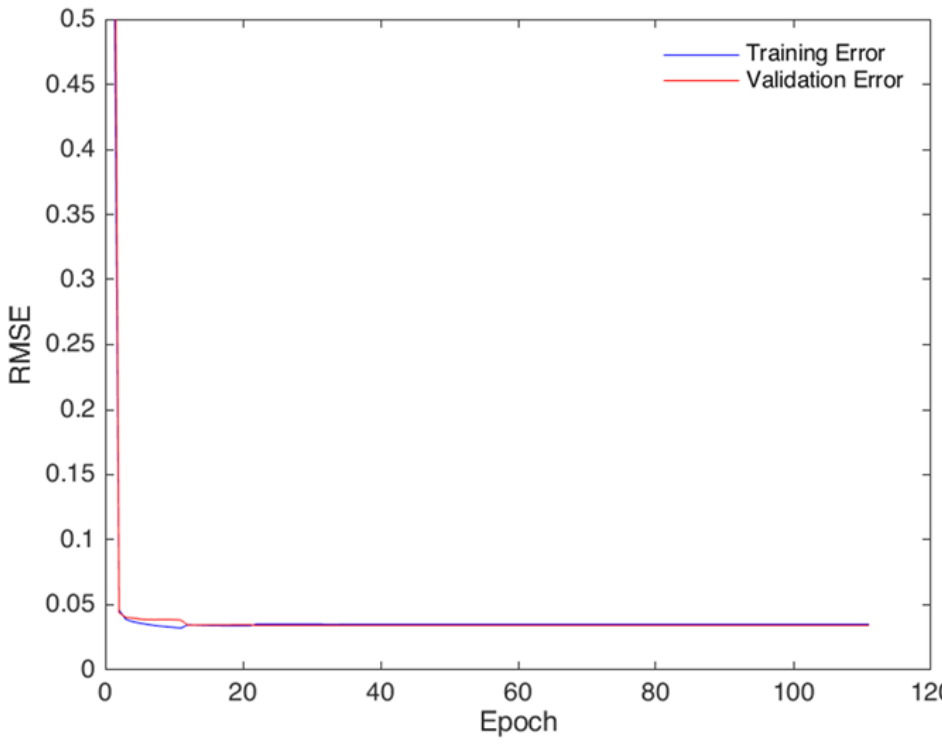
Figure 3. LSTM model performance during training and validation with the input parameters at a low latitude station Bangalore (IISC) in India.